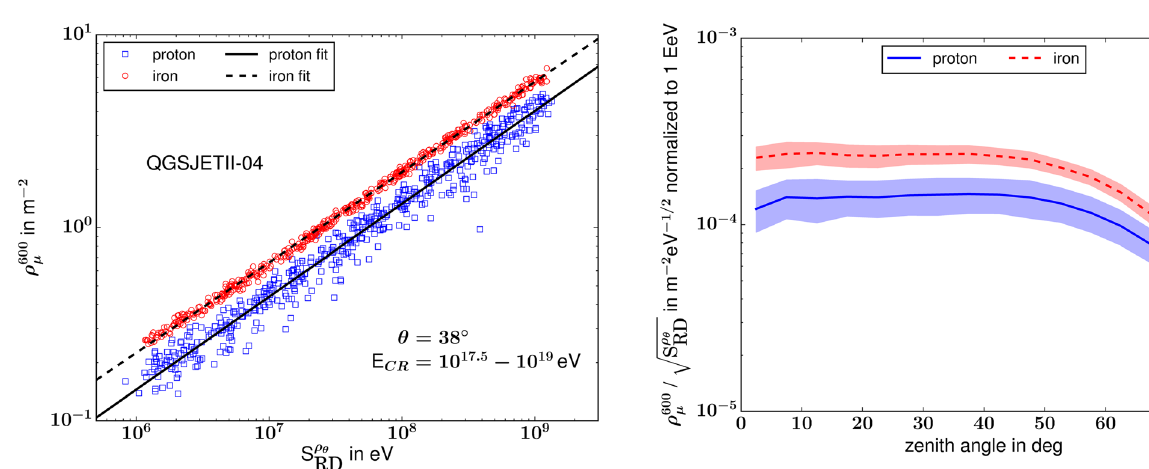
Fig. 8 Correlation between the muon density and the radiation energy and a power-law fit